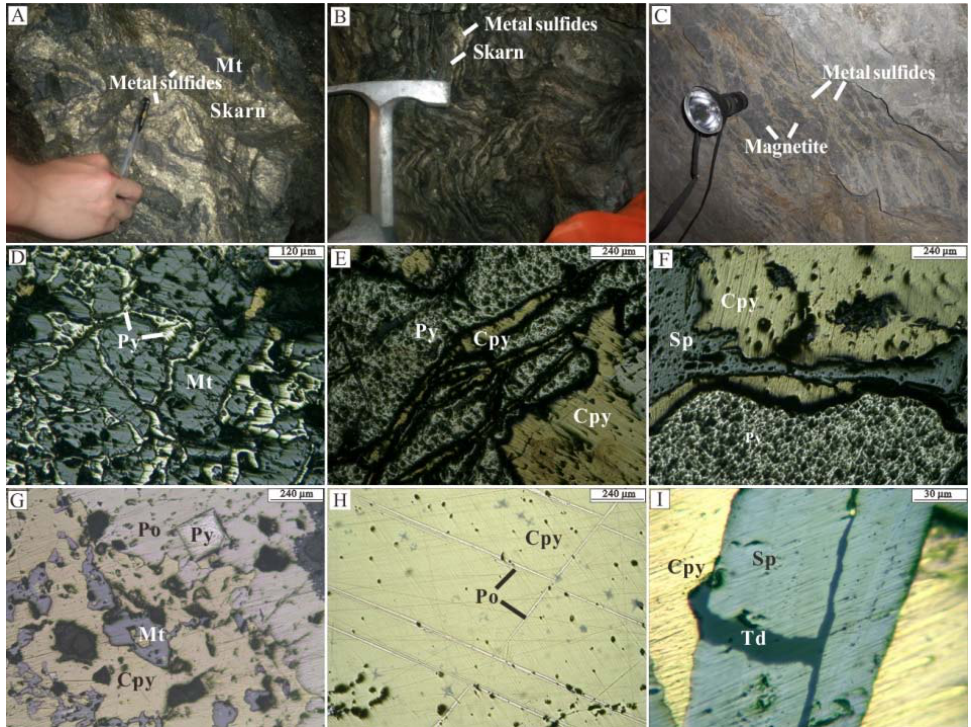
Figure 4. Typical ore structure and texture of the Dongguashan deposit. ( A , B ) Magnesian skarn and metal sulfides present as laminated structure. ( C ) Magnetite intruded by ore sulfide veins. ( D ) Magnetite intruded by pyrite (reflected light). ( E ) Vein-like chalcopyrite penetrating pyrite (reflected light). ( F ) Vein-like sphalerite penetrating chalcopyrite (reflected light). ( G ) Pyrrhotite contains pyrite (reflected light). ( H ) Chalcopyrite and pyrrhotite with exsolution texture (reflected light). ( I ) Tetrahedrite fills the fissure in sphalerite. Abbreviations: Py—Pyrite, Mt—Magnetite, Ccp—Chalcopyrite, Po—Pyrrhotite, Sp—Sphalerite, Td—Tetrahedrite, Bn—Bornite.